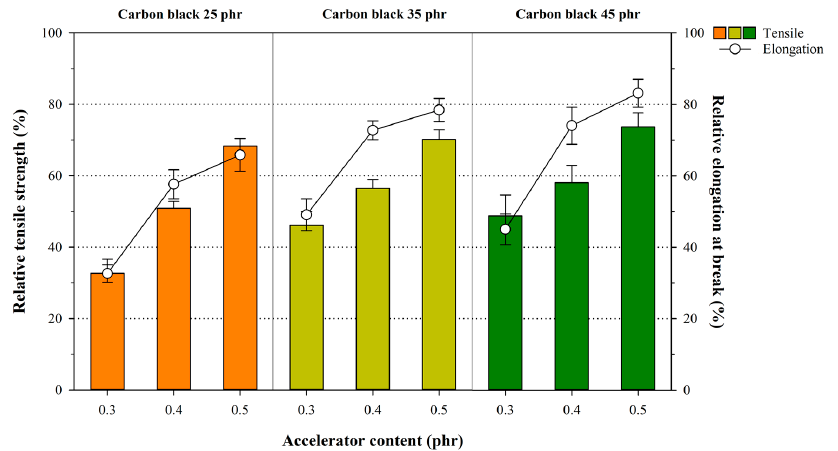
Figure 6. Variation in the relative tensile strength and the elongation at break in the NR samples after thermal aging.